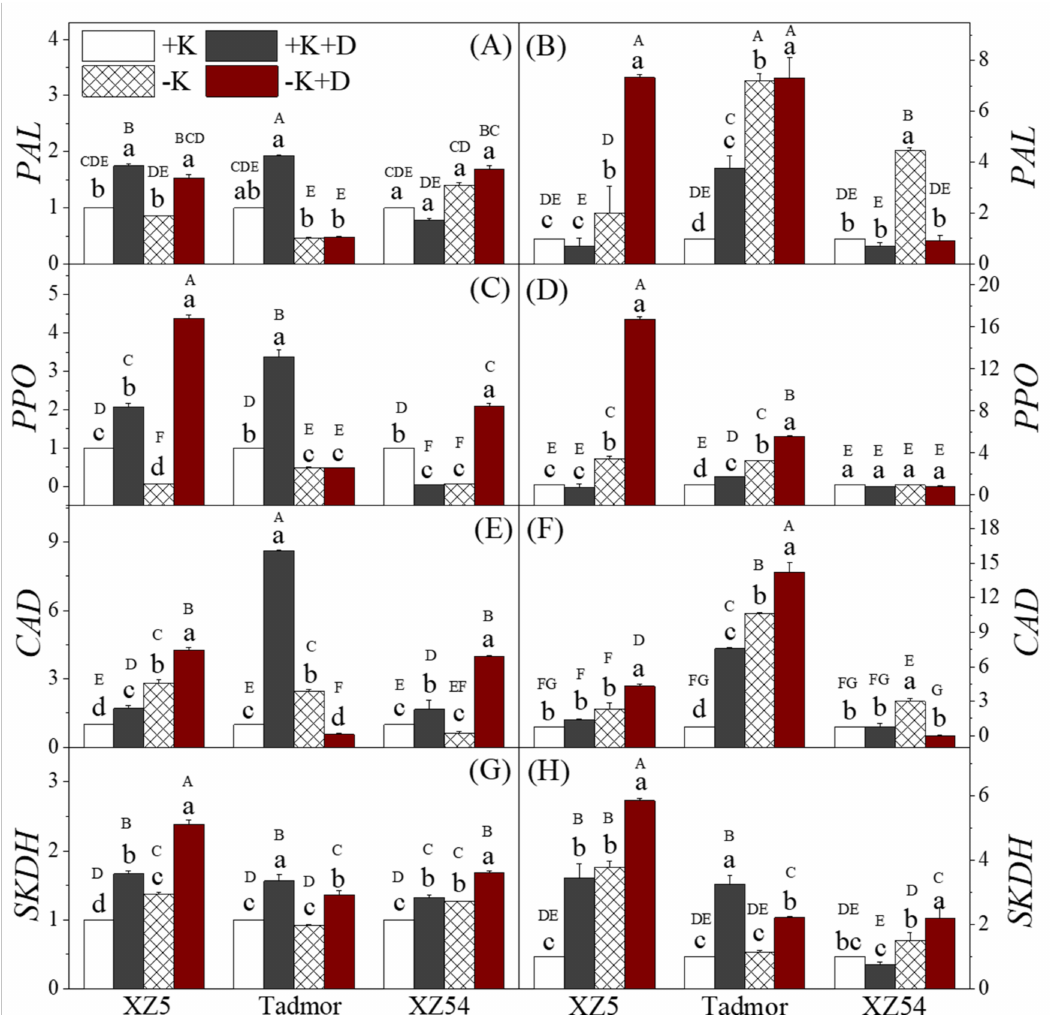
Figure 6. Secondary metabolism related gene expression analyzed by qRT-PCR in Tibetan wild barley XZ5 and XZ54, and cv. Tadmor. Barley plants were exposed to alone and combined stresses of drought and K deprivation, PAL, PPO, CAD and SKDH gene expression were studied in leaves ( A , C , E , G ) and roots ( B , D , F , H ) of three barley genotypes. Different capital and small letter(s) indicate significant differences ( p <0.05) among the genotypes and among the 4 treatments within each genotype, respectively. Error bars represent standard deviations ( n = 4). +K, +K+D, –K, and –K+D, correspond to basic nutrition solution with normal K of 1 mM K (BNS), BNS + 20% Polyethylene glycol 6000 (PEG), BNS without K (K deprivation), and BNS without K+ PEG,